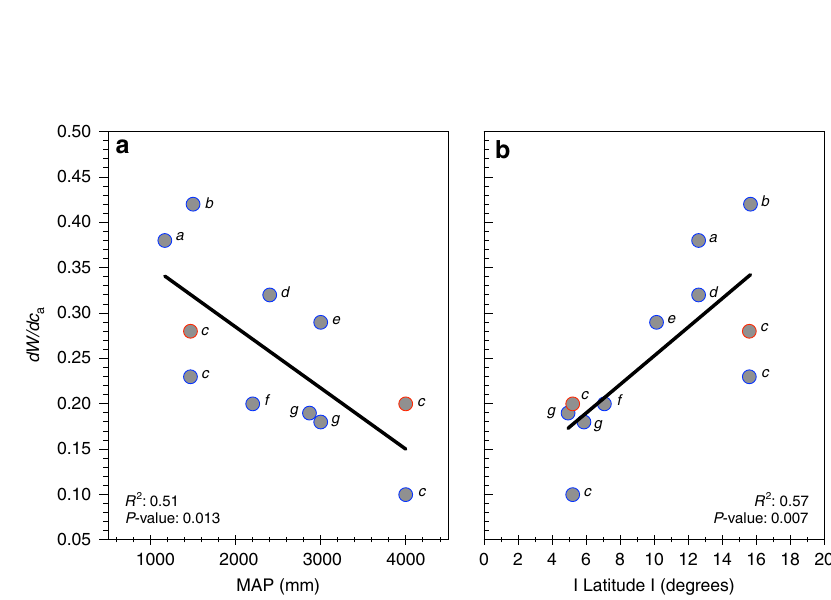
Relationships are shown for each site and study. The data were pooled (i.e., across species) for each site according to their nitrogen- fi xing status (non-legume or legume)